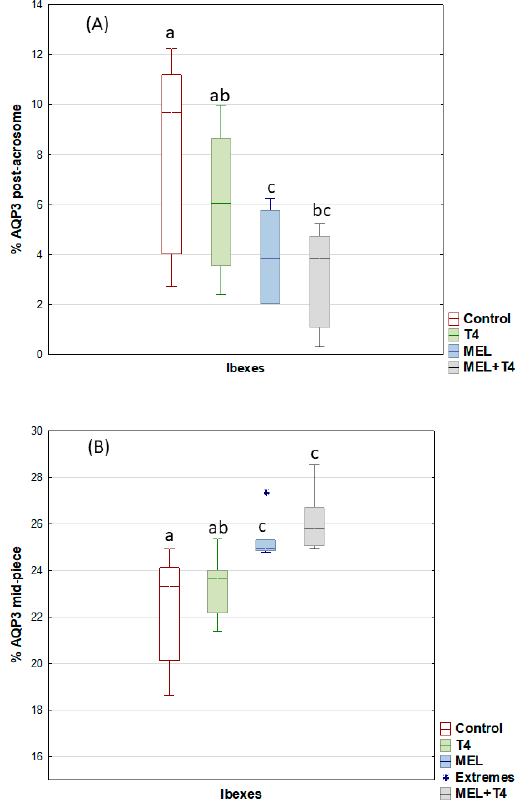
Figure 4. AQP3 expression as determined by immunocytochemistry labelling (ICC) in the post-acrosome ( A ) and midpiece ( B ) of ibex sperm (controls (red); treated with thyroxine (T4, green); treated with melatonin implants (MEL, blue); and treated with melatonin implants plus thyroxine (MEL+T4, gray)). The boxes spread form the 1st to the 3rd quartiles. Box plots show the median (horizontal line) and spread from the 1st to the 3rd quartiles; the whiskers extend from the smallest to the largest value. Extremes are shown as asterisks. Different letters (a,b,c) between boxplots indicate significant differences ( p < 0.05).